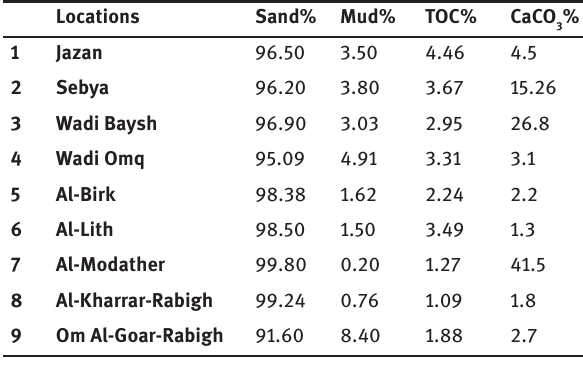
Table 1: Sediment characteristics for the studied mangrove swamps along the Red Sea.